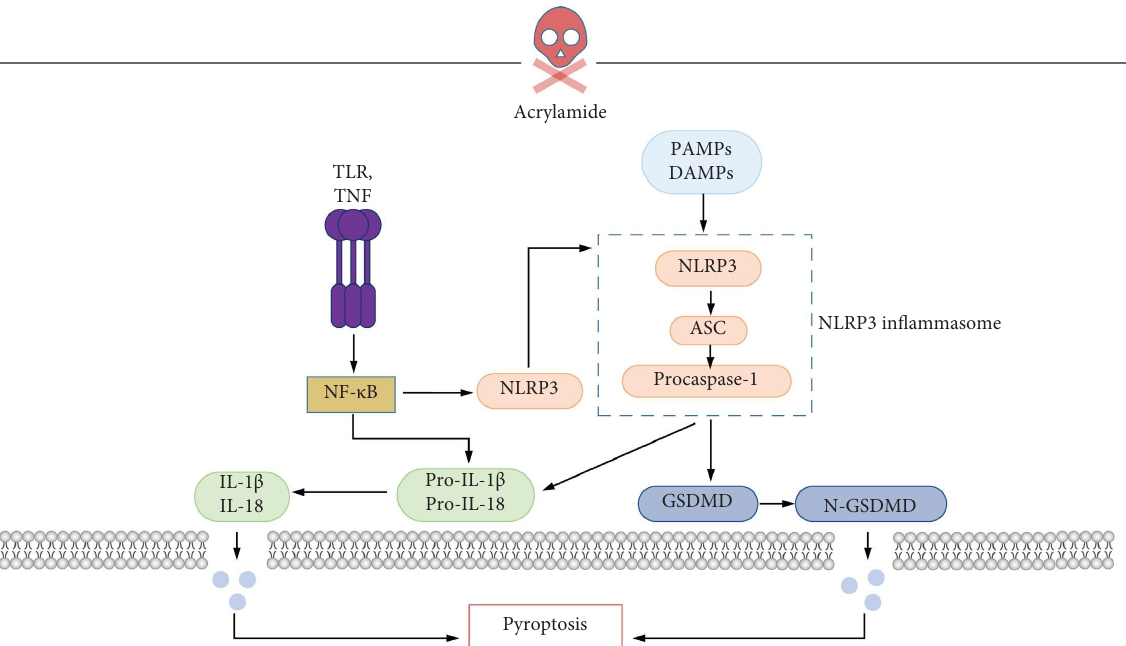
Figure 5: Molecular mechanisms of infammation pathways in AA-induced toxicity.